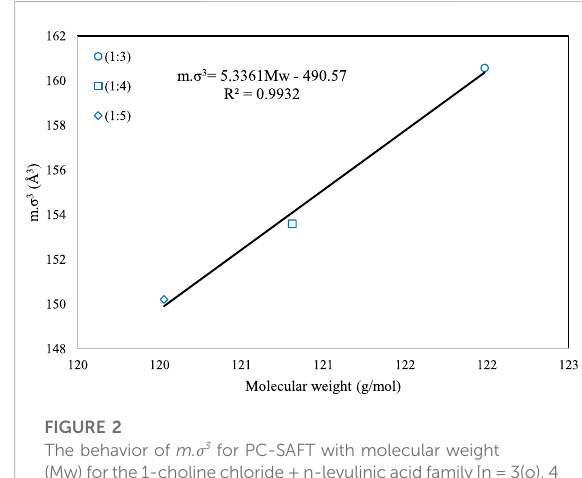
FIGURE 1 The behavior of m. σ 3 for PC-SAFT with molecular weight (Mw) for all of the investigated DESs in this study.